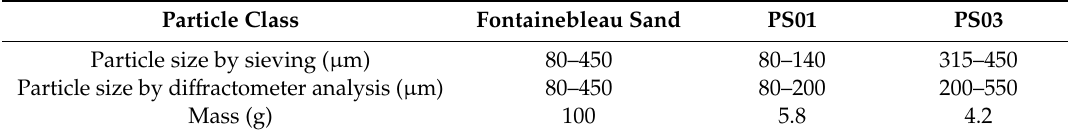
Table 1. Mass proportions of di ff erent classes of Fontainebleau sand particle size.